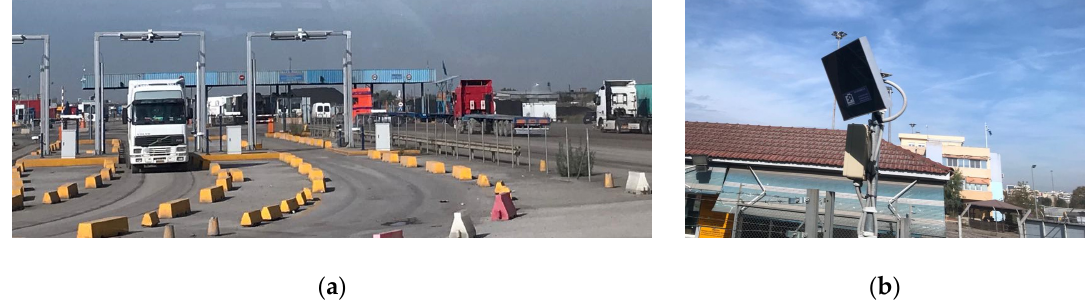
Figure 6. Data coming from RFID sensors in the gates of the Port of Thessaloniki: ( a ) RFID arcs at the entrance to the port of the trucks gate (16); ( b ) RFID tag and vehicle detection plate at the common-vehicles gate (10A).